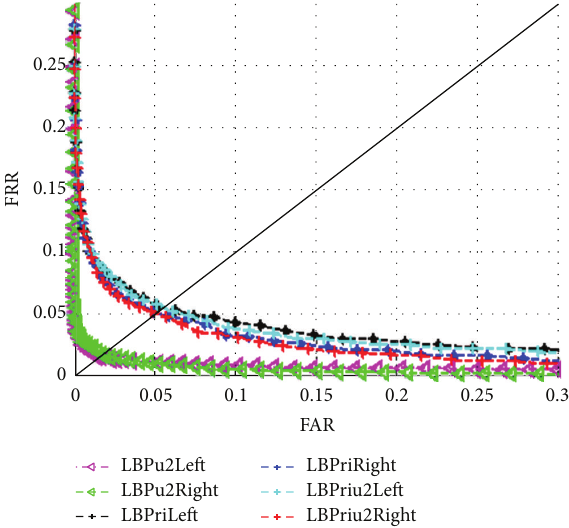
Figure 11: Comparison of ROC curves based on different